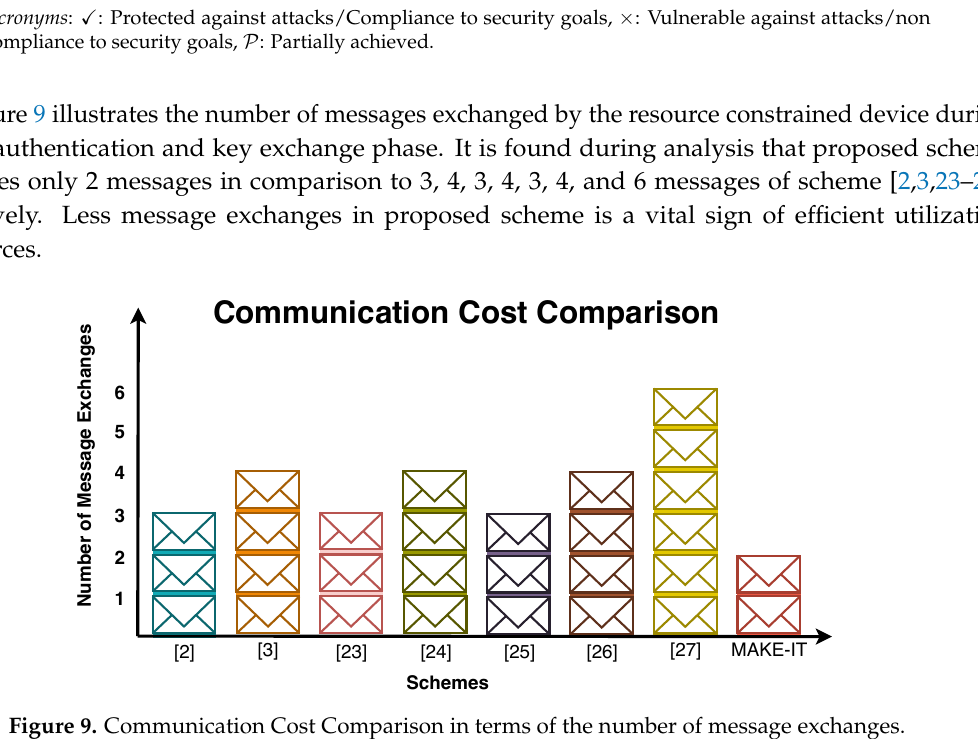
Figure 9. Communication Cost Comparison in terms of the number of message